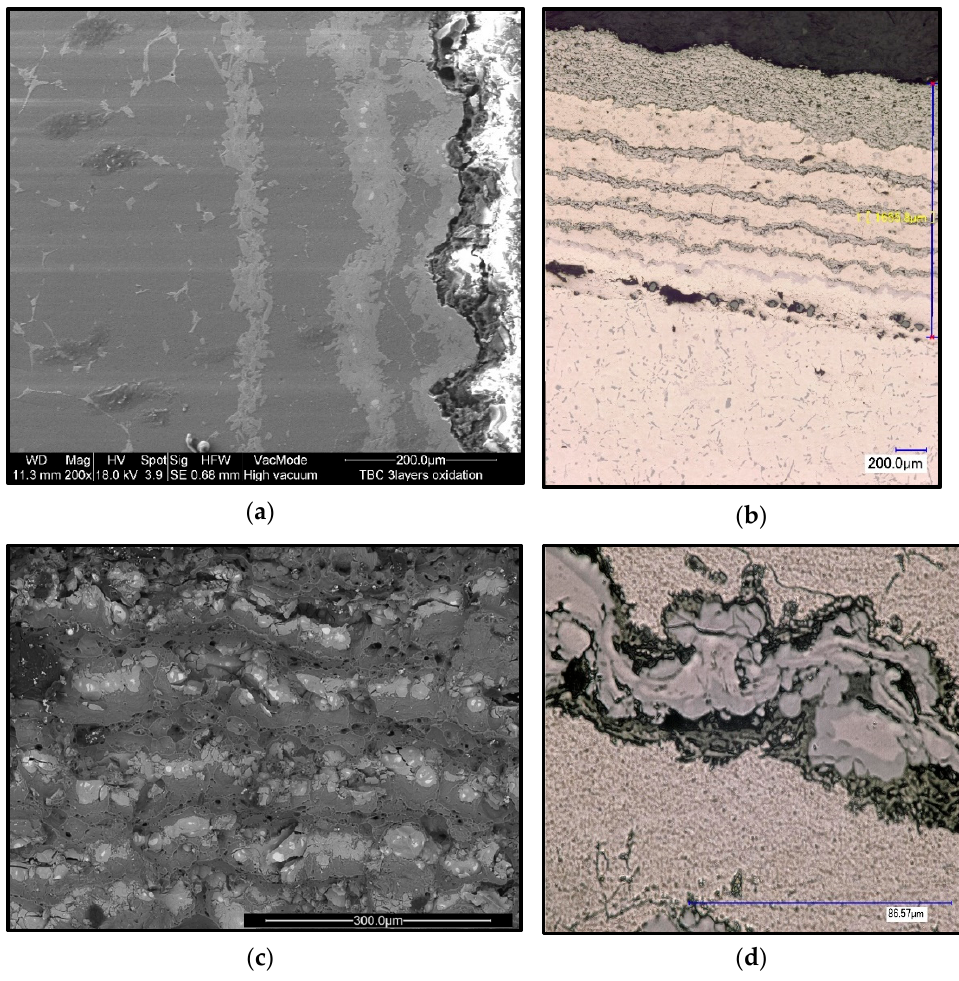
Figure 13. Microstructure topography after CS ( b ) and sintering at 600 °C ( a , c , d ): ( a ) SEM micrograph of SHS717-Al 3-layer TBC; ( b ) OM micrograph of AISI304-(Al + 50%ZrO 2 ) 12-layer TBC after CS; ( c ) SEM micrograph of SHS717-Al 6-layer TBC fractured surface; ( d ) OM micrograph of AISI304-(Al + 50%ZrO 2 ) 12-layer TBC, magnification ×2500.